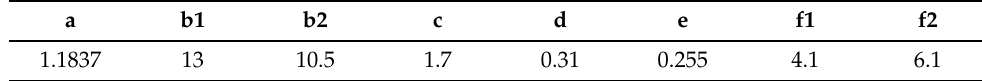
Table 1. Parameters used in Equation (1).